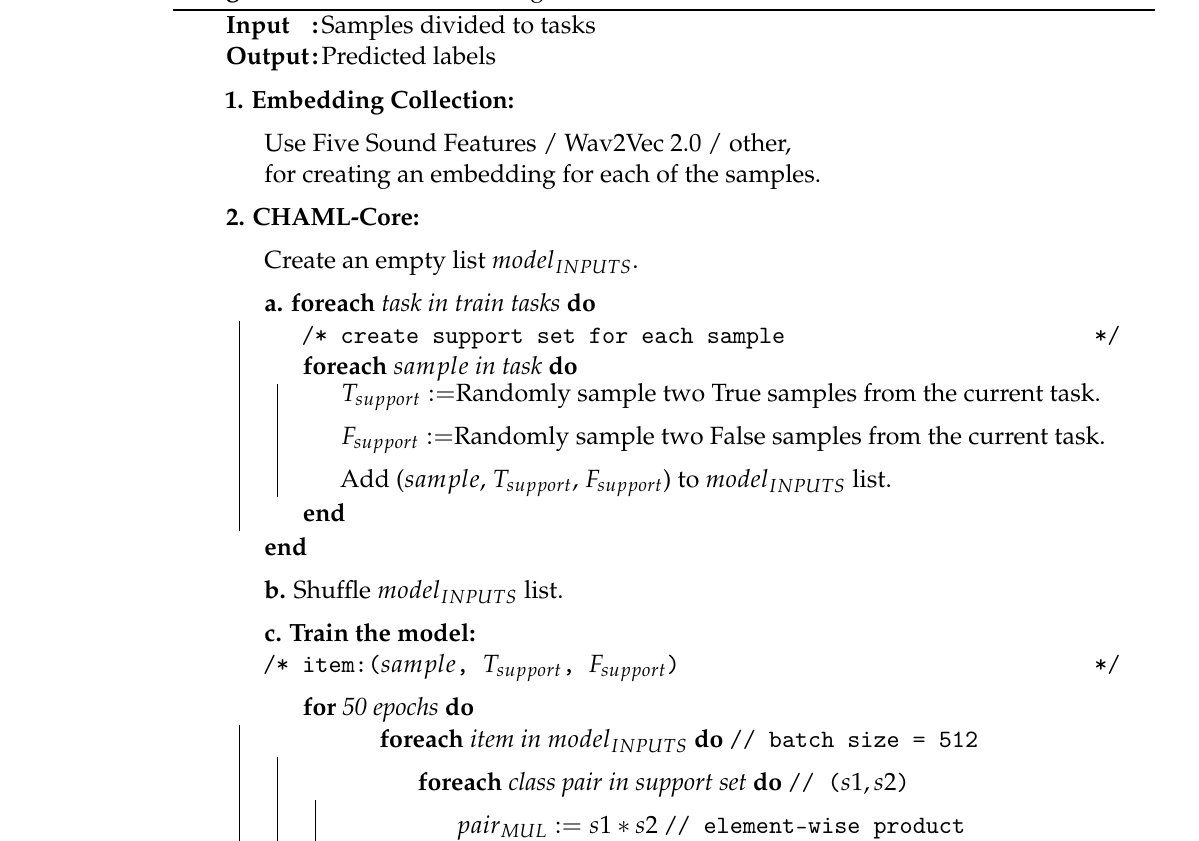
Algorithm 1: CHAML Training